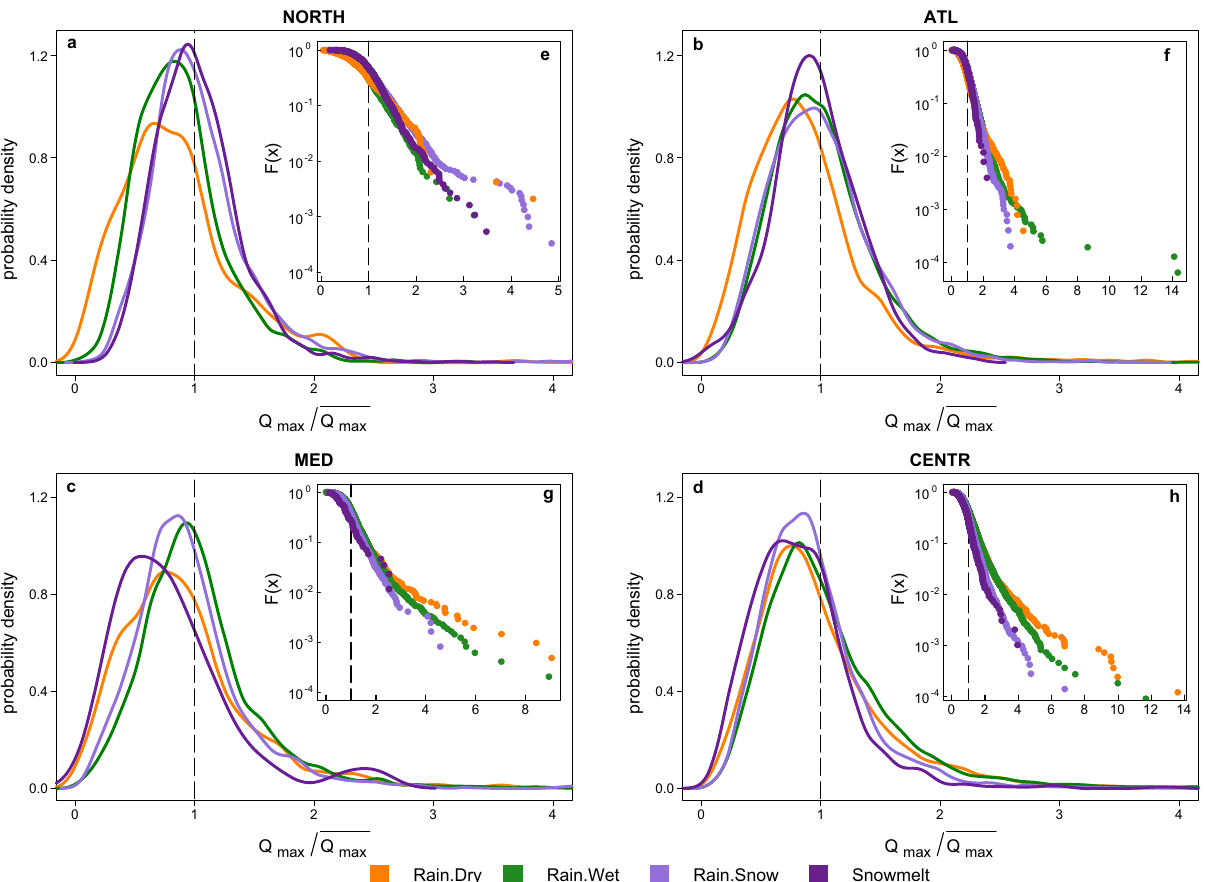
Fig. 3 Regional probability distributions of fl ood magnitudes of different fl ood generation processes. a – d Kernel density estimates of fl ood magnitudes of annual maxima Qmax scaled by mean maximum annual fl ood of all fl ood events for each study catchment) aggregated for each region and fl ood generation process. The right tails of probability density functions are only shown up to the value of 4 (four times the mean maximum annual fl oods) and displayed in full in the corresponding insets. In all panels, the value of 1 on x-axes corresponds to the mean maximum annual fl ood. The signi fi cance of fl ood magnitude distributions differences for different generation processes is tested with the two-sided Kolmogorov – Smirnov test ( α = 0.01) with a correction for pairwise comparisons by using a procedure based on the false discovery rate (see Supplementary Table 1). In the NORTH only the differences between the distributions of Snowmelt and Rain.Snow fl ood magnitudes are not signi fi cant. In the ATL only the distribution of Rain.Dry fl oods is different from all others. In the CENTR and in the MED regions the distributions of magnitudes are signi fi cantly different among all four fl ood generation processes apart from the pair Rain.Dry and Snowmelt fl oods in the latter region. e – h Semi-log plots of the exceedance probability of fl ood magnitudes (F(x), calculated using Weibull plotting position of fl oods individually for each generation process) for all study catchments visualising particularly the right tails of regional distributions. The extent of x axes depends on the range of the recorded fl ood magnitudes in the catchments of corresponding